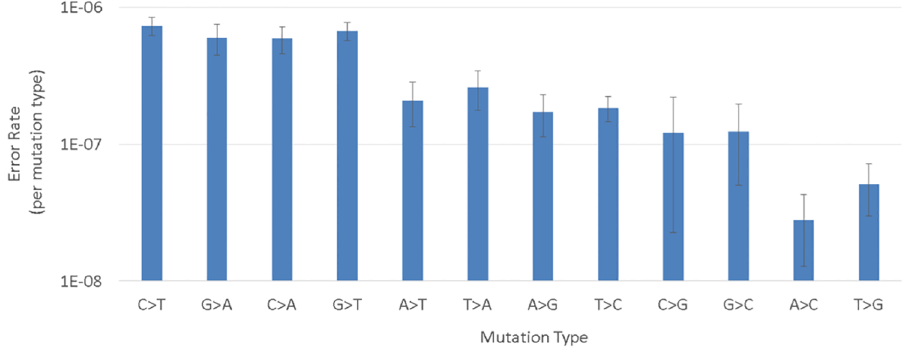
Fig 7. Average mutation rate as a function of mutation type across the 12 runs used to measure FPR. The error rate was calculated per run as the count of all non-reference calls per mutation type over total bases sequenced. Error bars represent the standard error of the